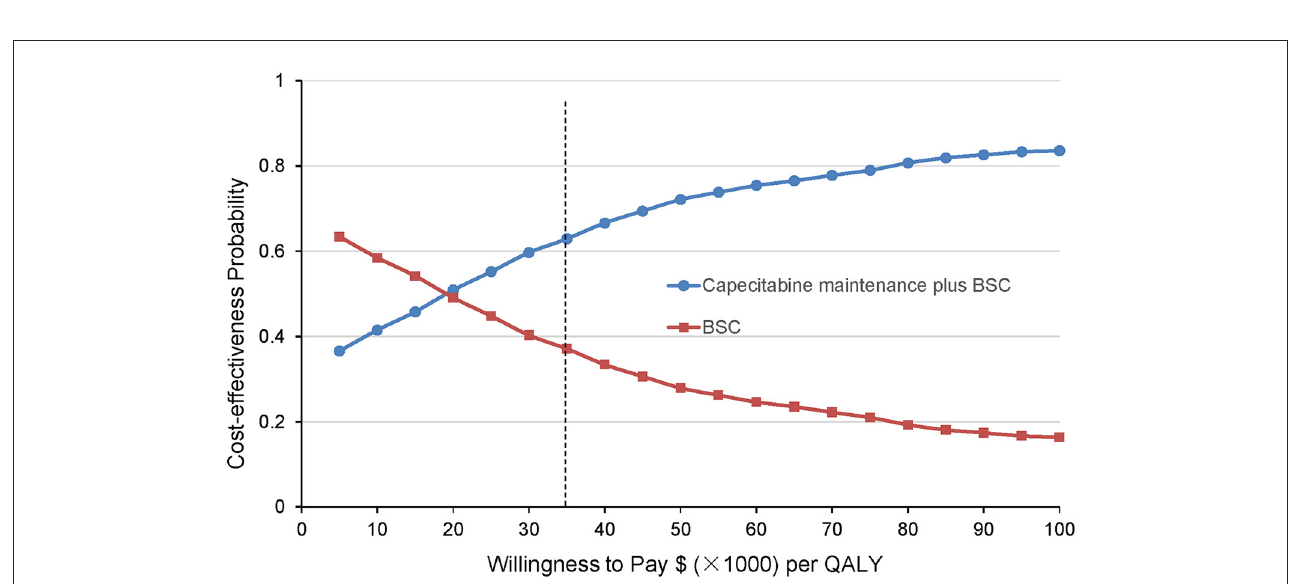
FIGURE4 Cost-effectiveness acceptability curves derived from the probabilistic sensitivity analysis. The results are presented as probabilities that the treatment option is cost-effective at different willingness-to-pay thresholds. The black dashed line indicates the WTP threshold in China ($36 007/QALY). BSC, best-supported care; QALY, quality-adjusted